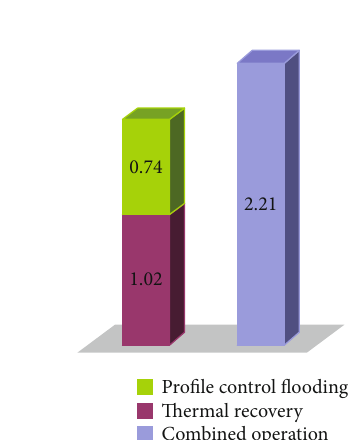
Figure 7: Production pro fi les the B31 well.